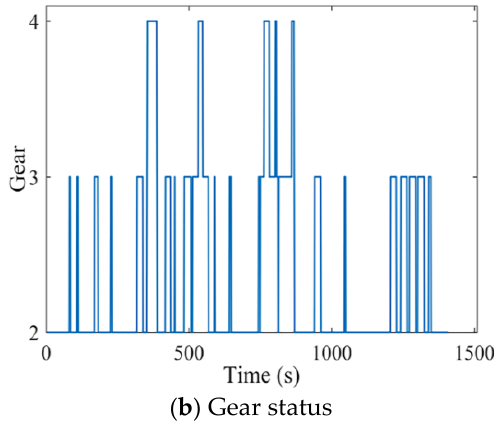
Figure 8. WVUCITY working condition.